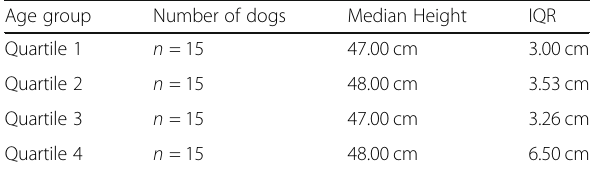
Table 9 Comparison of height and age of